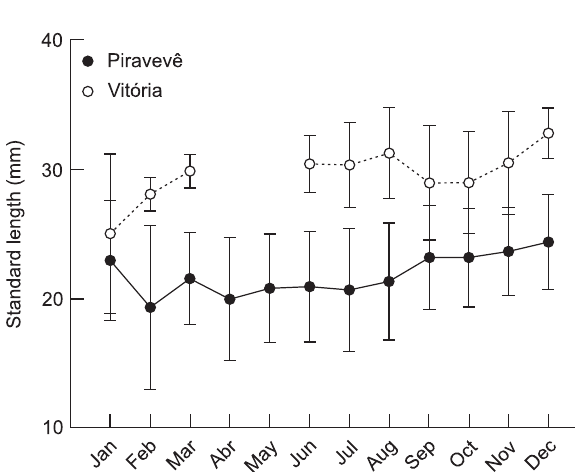
Figure 4. Mean standard length by month and sub-basin for H. marginatus , sampled in two sub-basins of the Ivinhema River. Ver- tical bar represents standard deviation of average values.